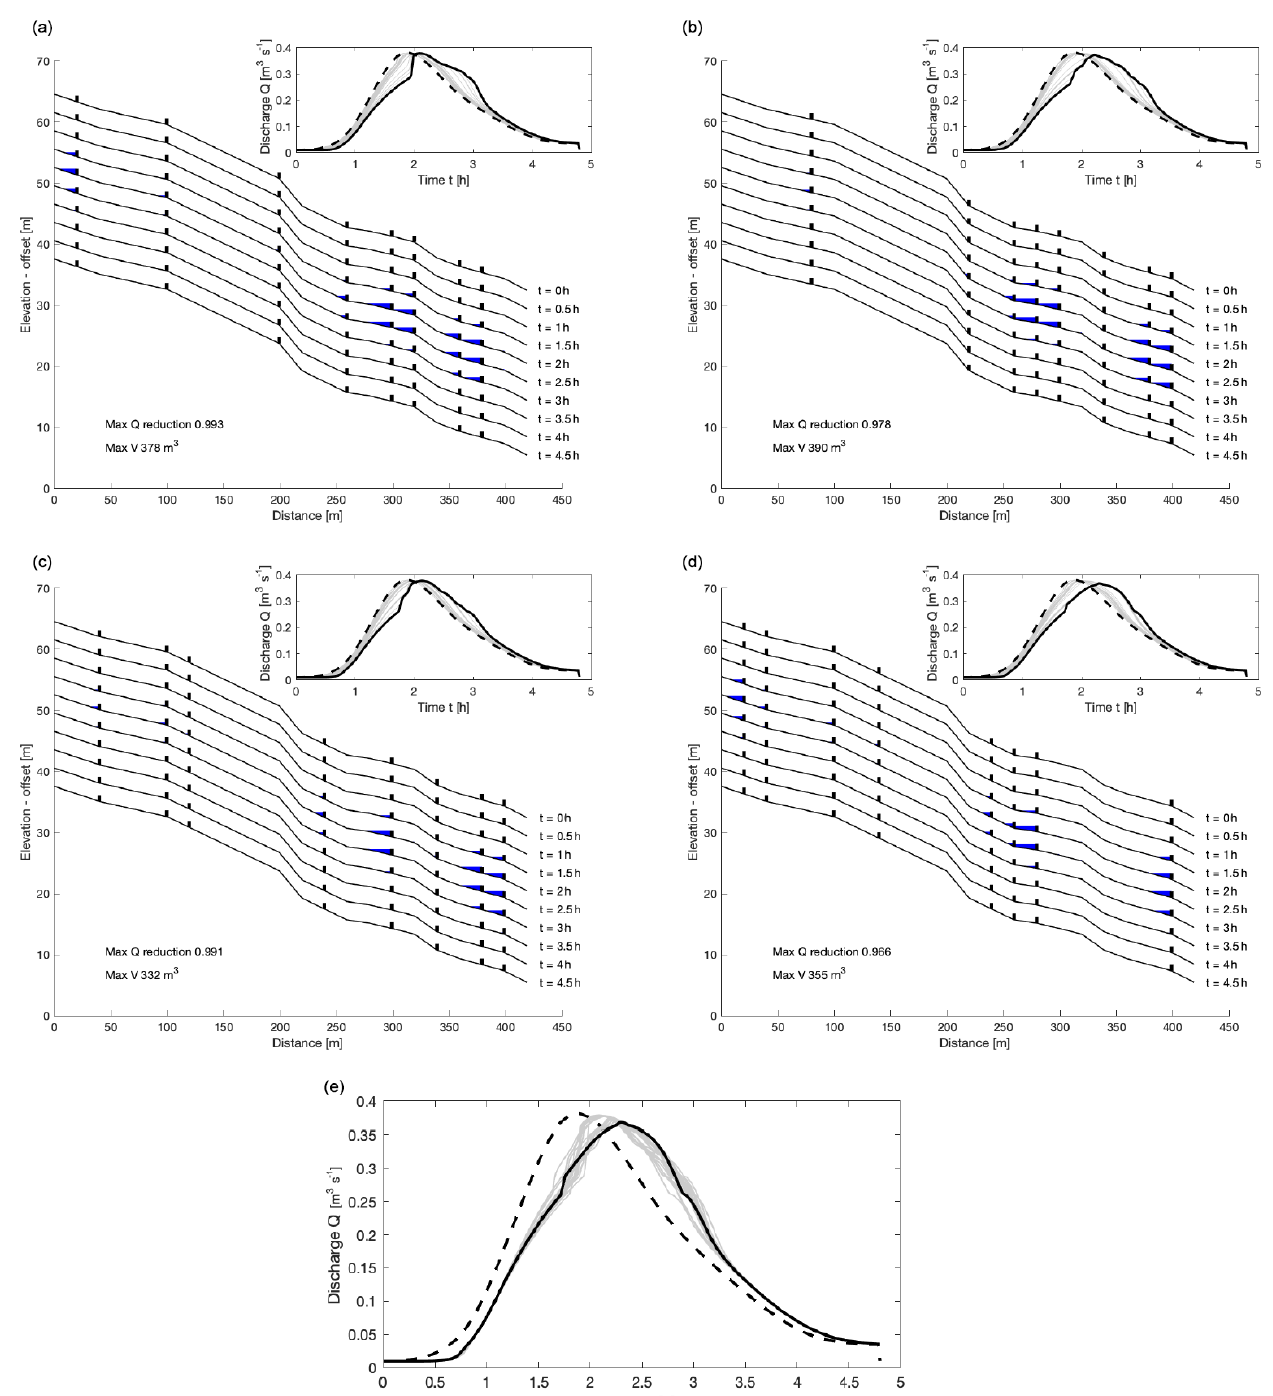
Figure 14. Example model runs with random arrangements of eight dams. Panel (e) shows the downstream discharge for each of 20 different arrangements, compared with the input hydrograph (dashed), and with the one that gives the greatest peak reduction (97%) highlighted in black, which is (d) of the examples above and results in a maximum volume stored of 355m 3